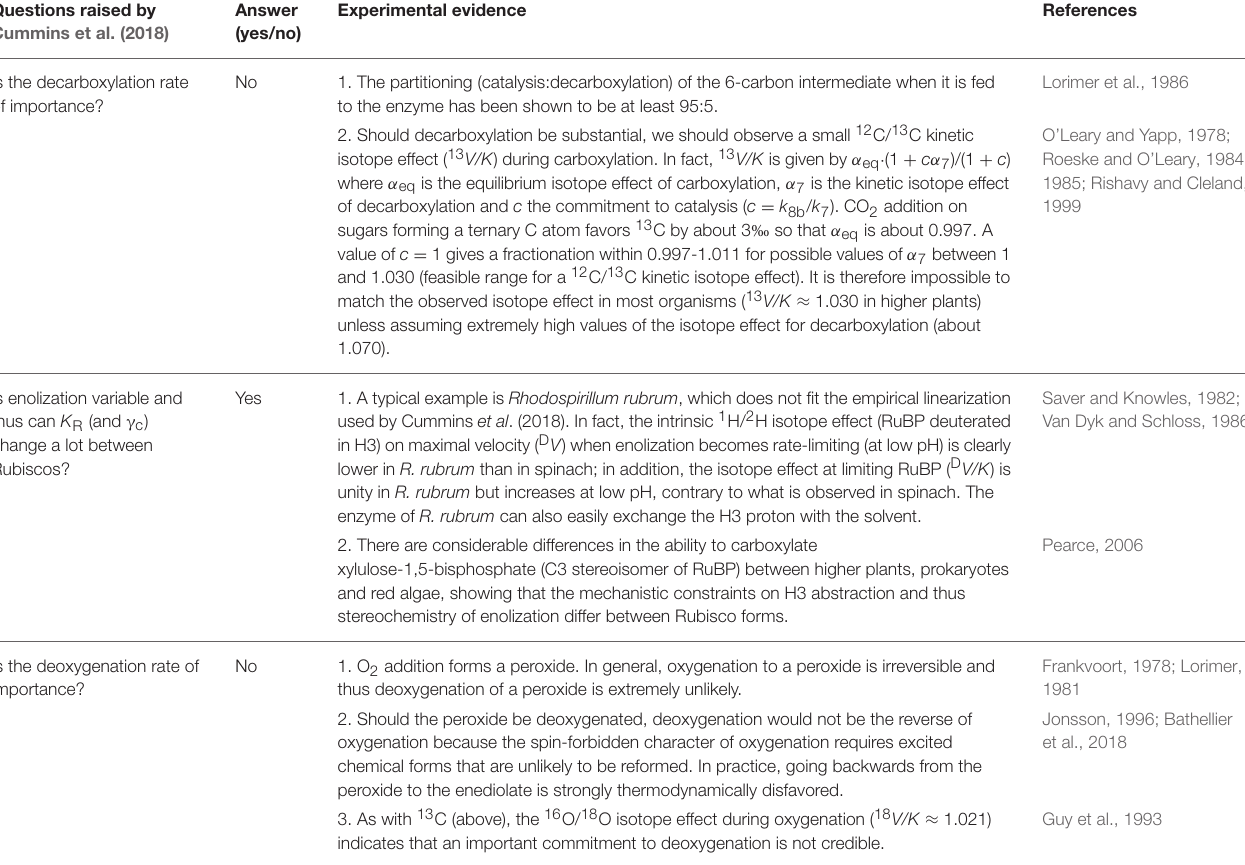
TABLE 1 | Direct evidence that the enolization equilibrium differs between Rubisco forms, and that decarboxylation and deoxygenation are negligible. Questions raised by Cummins et al.